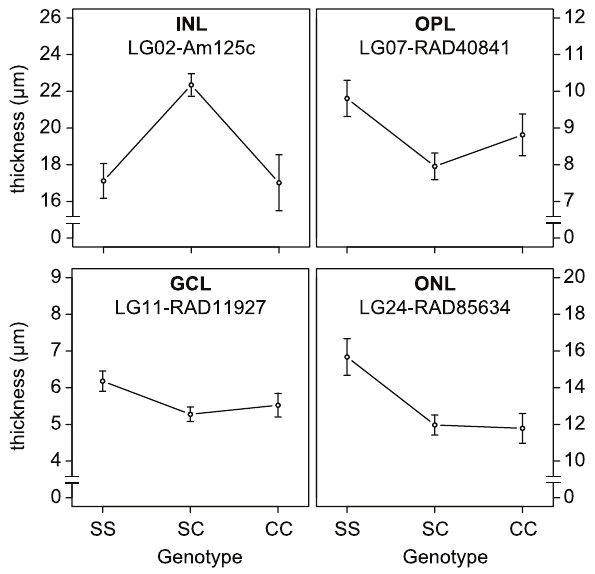
Figure 4. Mean thickness of retinal layers among genotypic classes at each QTL. Mean values of inner nuclear (INL), outer plexiform (OPL), ganglion cell (GCL), and outer nuclear (ONL) layer thickness are plotted for genotypic classes at the peak marker for each QTL (see Figure 3). The distributions of mean OPL, GCL, and ONL thickness indicate that cavefish alleles are inherited dominantly and contribute to a clear decrease in retinal thickness. The distribution of mean INL thickness indicates that cavefish alleles for this QTL may be inherited overdominantly. Error bars indicate standard deviation. SS: surface fish homozygote; CC: cavefish homozygote; SC: heterozygote.